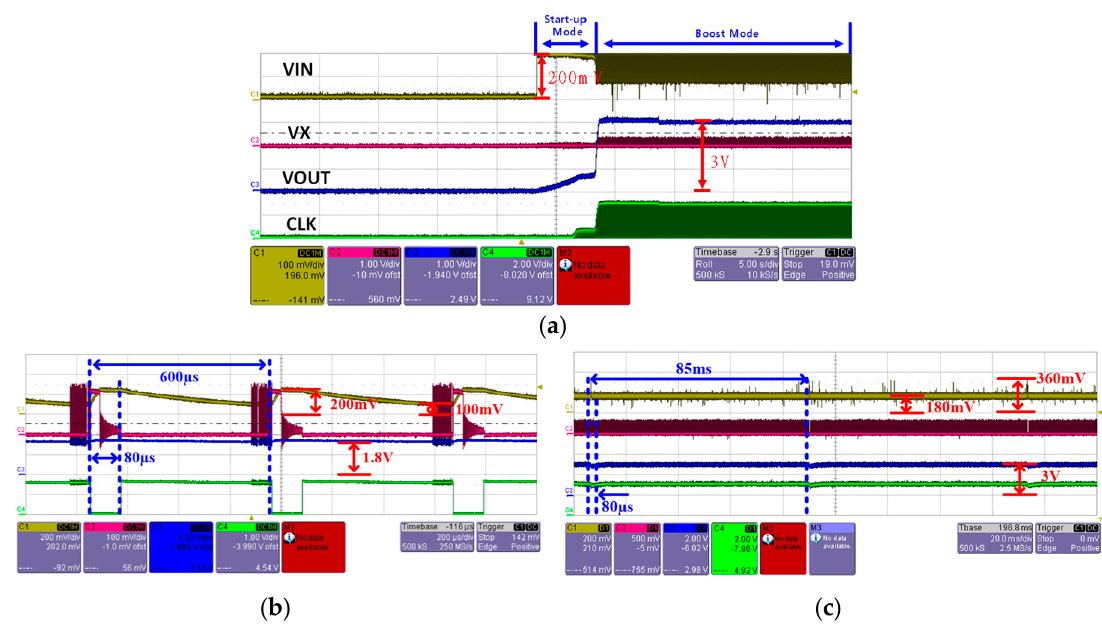
Figure 12. The waveforms of ( a ) the cold start operation, ( b ) the MPPT operation, and ( c ) MPPT period controller operation.